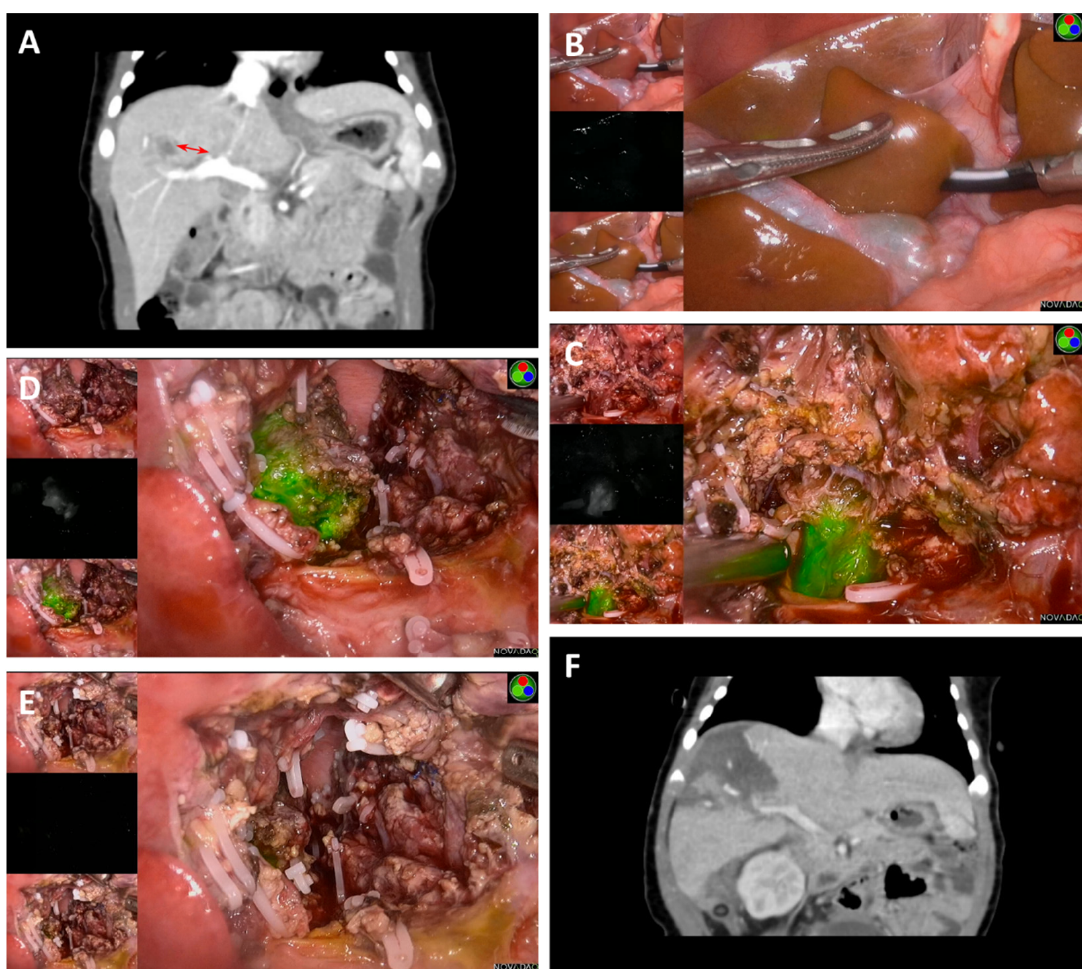
Figure 3. ICG fluorescence-guided laparoscopic hepatectomy of Segments 5, 6, and 7. ( A ) Preoper- ative CT image to assess tumor size and extent. ( B ) Irregular fluorescence was observed between the tumor and normal liver tissues in intraoperative fluorescence mode (black arrow). ( C ) No obvi- ous fluorescence was seen in the tumor (red arrow). ( D ) No signs of tumor residues or recurrence were observed via CT 12 months after surgery.